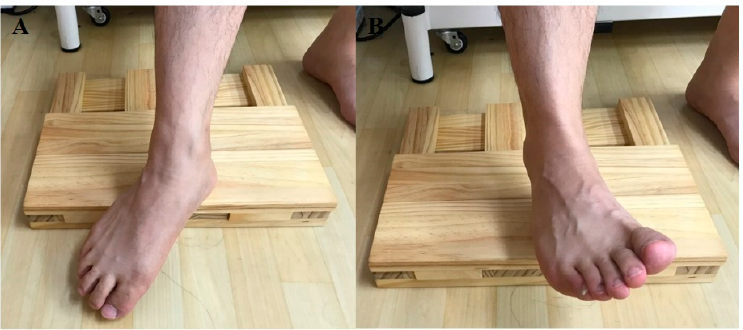
Figure 5. D1 patterns: ( A ) plantarflexion–pronation–eversion with toe flexion, ( B ) dorsiflexion–supination–inversion with toe extension.